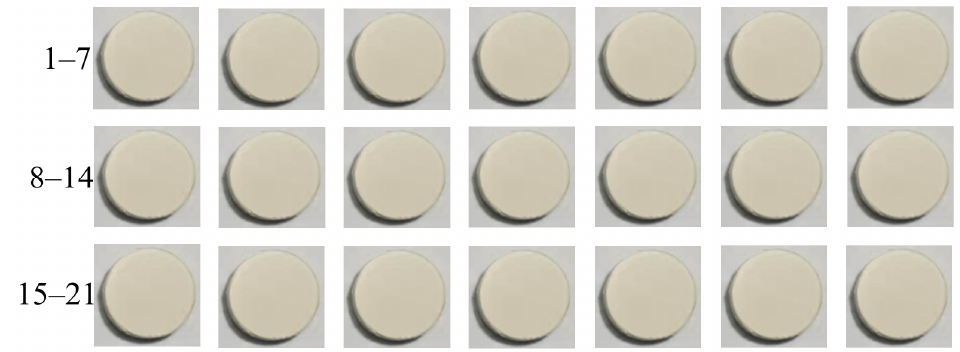
Figure 1. Physical diagram of the experimental samples with 21 different doping levels.